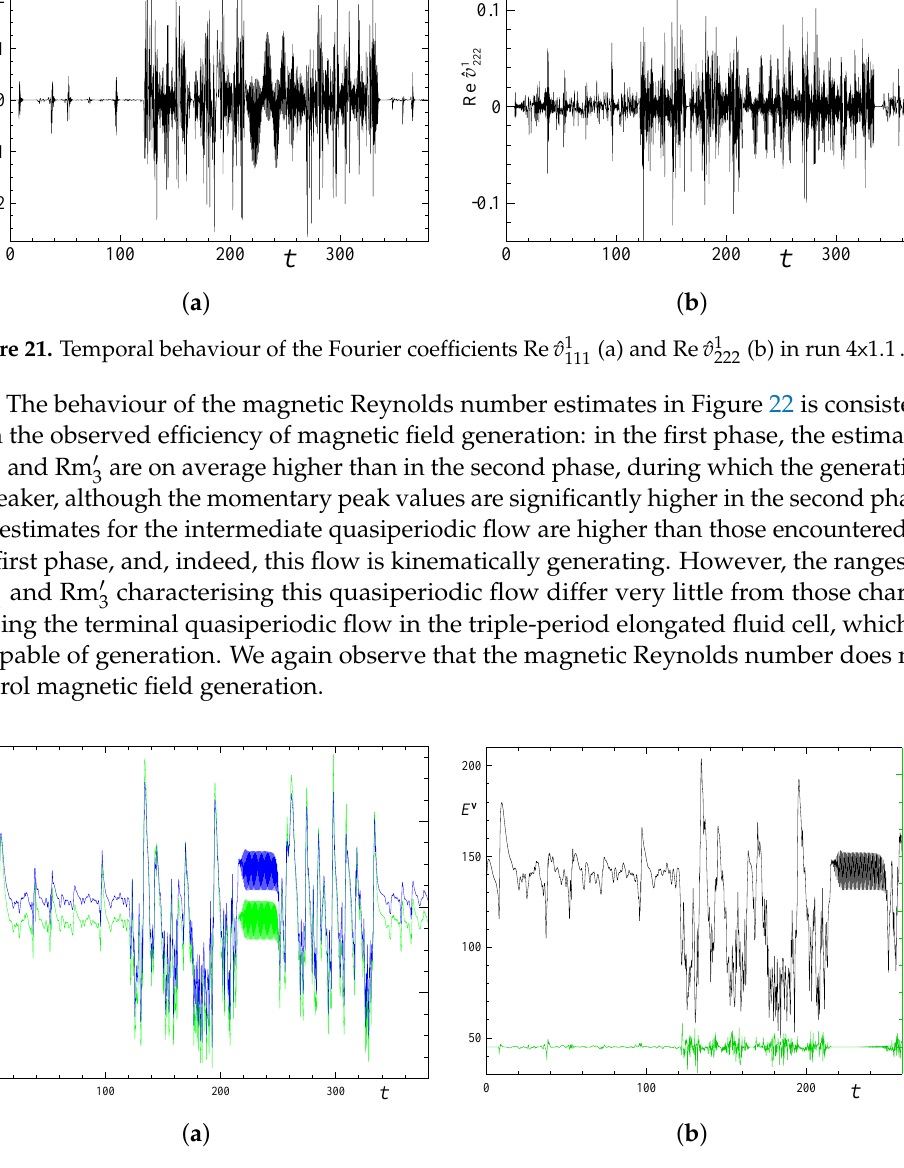
(green line) and 1